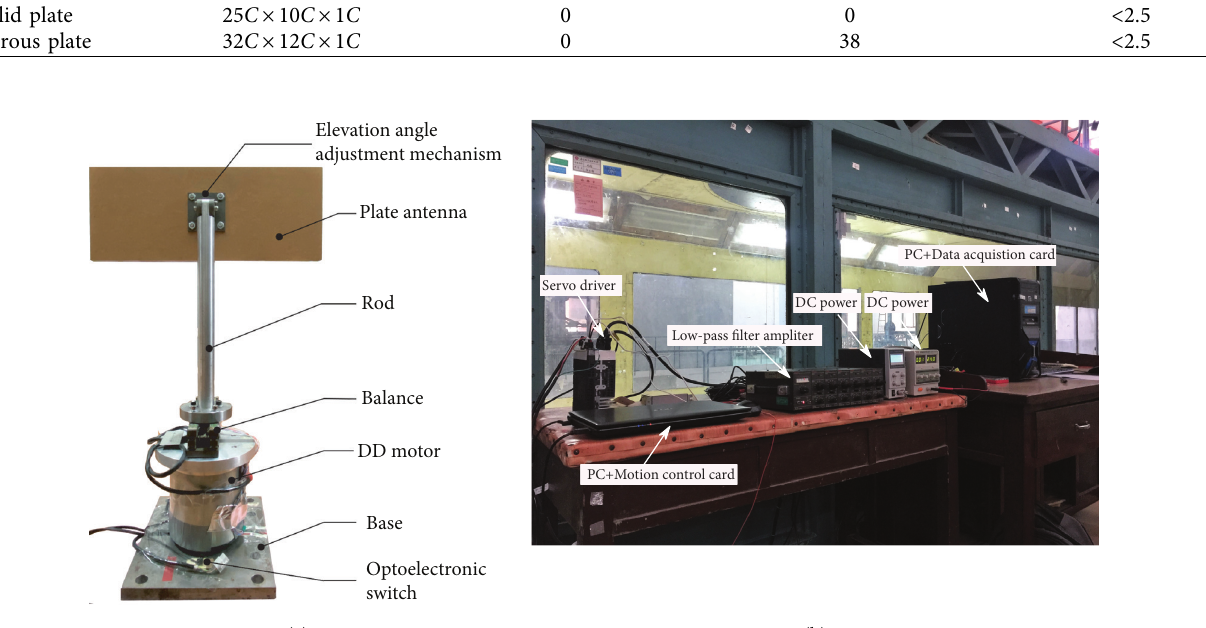
Figure 2: Wind tunnel dynamic force measurement test platform. (a) Overall driving and model connection method; (b) motion control and data acquisition